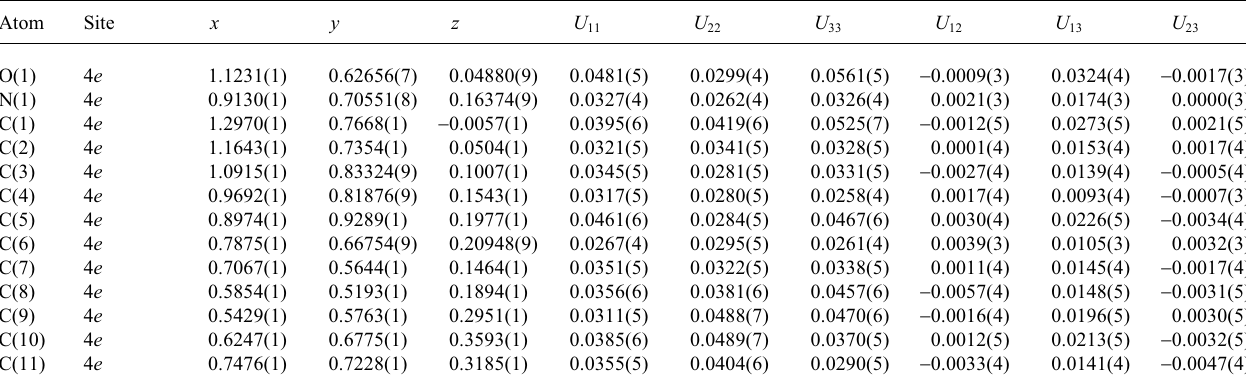
Table 3. Atomic coordinates and displacement parameters (in Å 2 ).